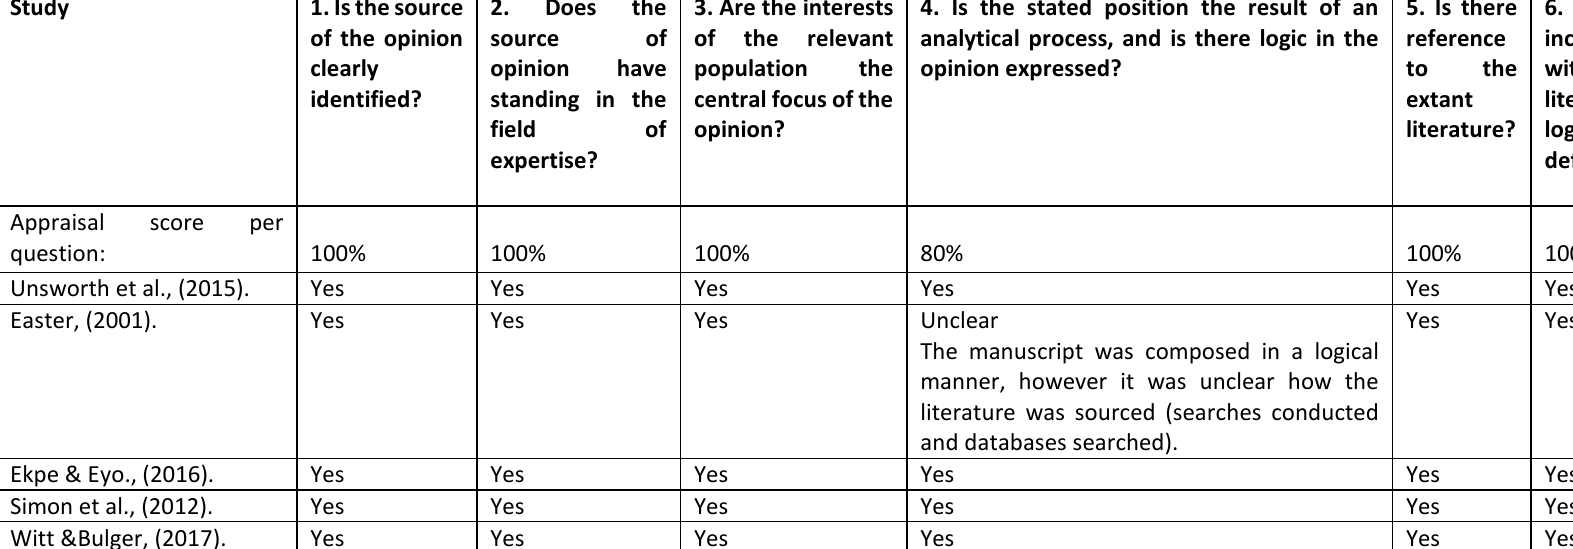
TABLE 8-A1: Text and opinion studies detailed appraisal.